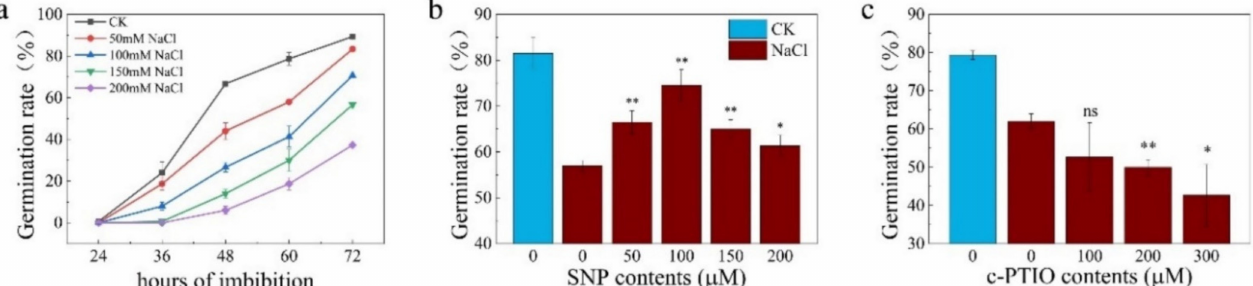
Figure 1. Nitric oxide promotes seed germination under salt stress. ( a ) Seed germination under different concentrations of salt solution; ( b ) Seed germination rate at 60 h under CK (water) and 100 mM NaCl plus different concentrations of SNP (0, 50, 100, 150 and 200 µ M); ( c ) Seed germination rate at 60 h under CK and 100 mM NaCl plus different concentrations of cPTIO (0, 100, 200 and 300 µ M). The data are the means of three independent replications ( n = 50) ± SD. The asterisk (* and **) indicates a significant difference at the p < 0.05 and p < 0.01 level, respectively, and ns means not significant, by Student’s t -test